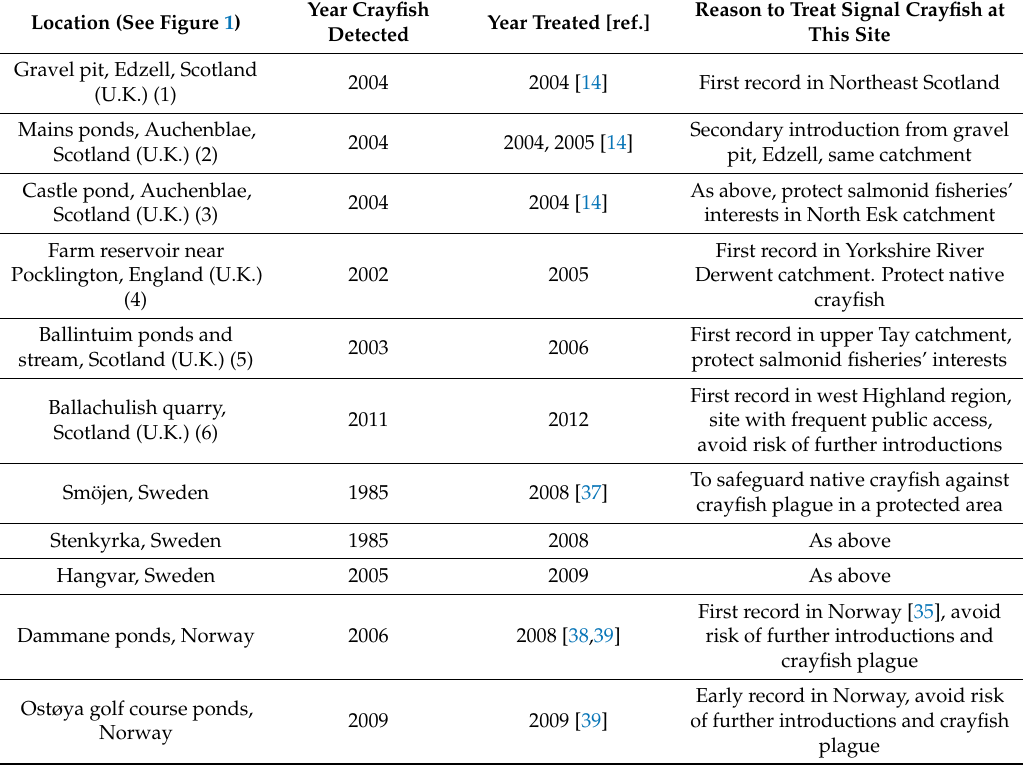
Table 1. Biocide treatment projects against signal crayfish 2004–2012 and locations and reasons for site